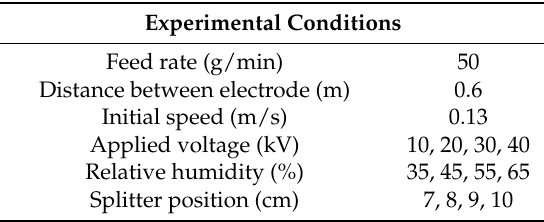
Table 2. Parameters used in the induction electrostatic separator.